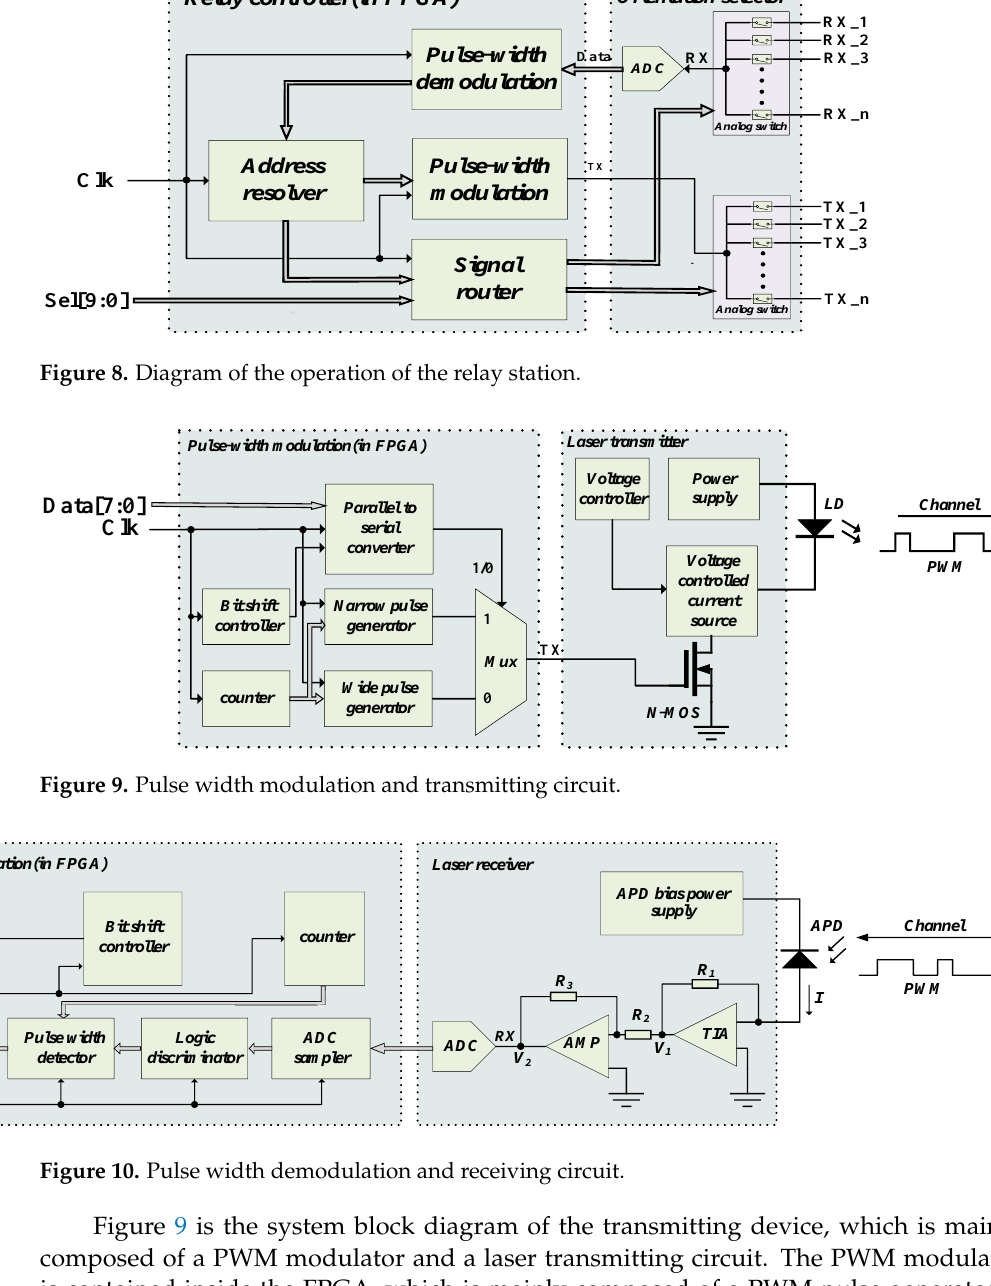
different receiving targets through the PWM modulator, thus realizing point-to-multipoint Figure 7. Hardware composition block diagram of a point-to-multipoint free-space optical commu- free-space optical communication. nication system.